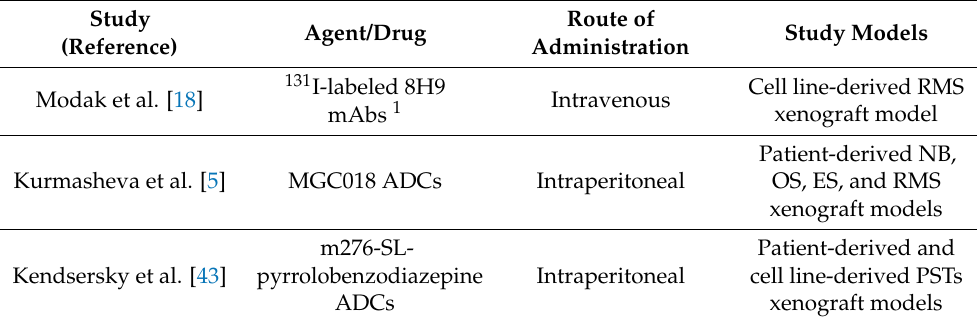
Table 1. B7-H3-targeting mAb-based anti-tumor agents in preclinical studies involving extracranial PSTs.